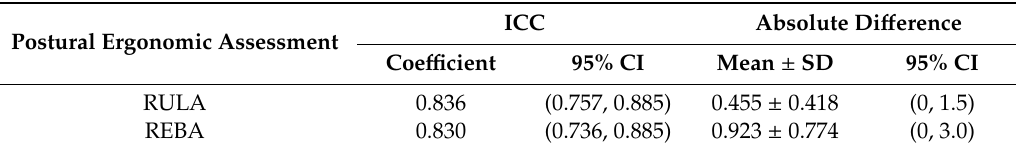
Table 1. Intraclass correlation coe ffi cient (ICC) and absolute di ff erence of RULA / REBA scores between the developed system and the expert raters.